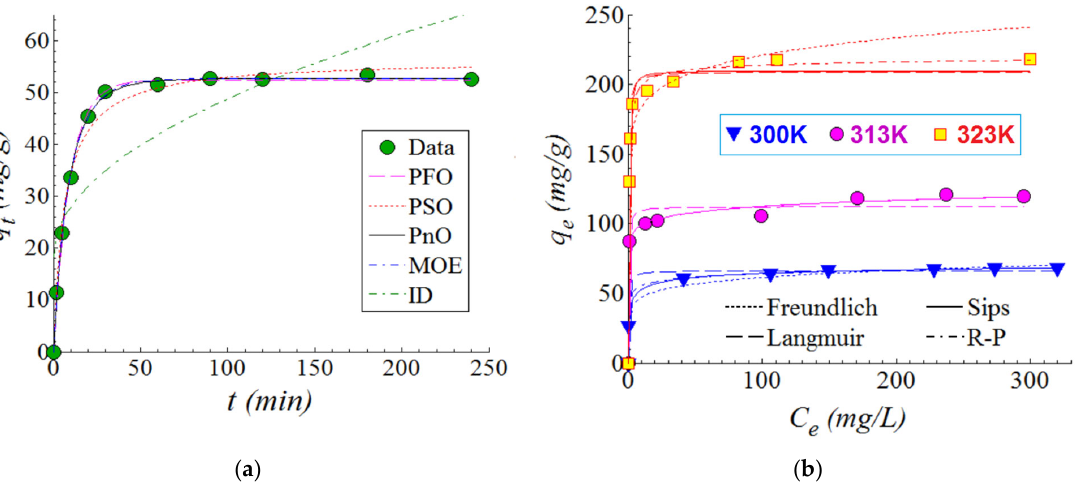
Figure 5. Adsorption of MB cationic dye onto the surface of the SPEEK adsorbent: ( a ) adsorption kinetics (experimental data and mathematical models) at T = 300 K, pH 6.0 ± 0.2, SD = 2 g/L, and C 0 = 100 mg/L; ( b ) adsorption isotherms (experimental data and mathematical models), conditions: SD = 2 g/L, pH 6.0 ± 0.2, t = 180 min; solid, dashed and dotted lines represent predictions given by mathematical